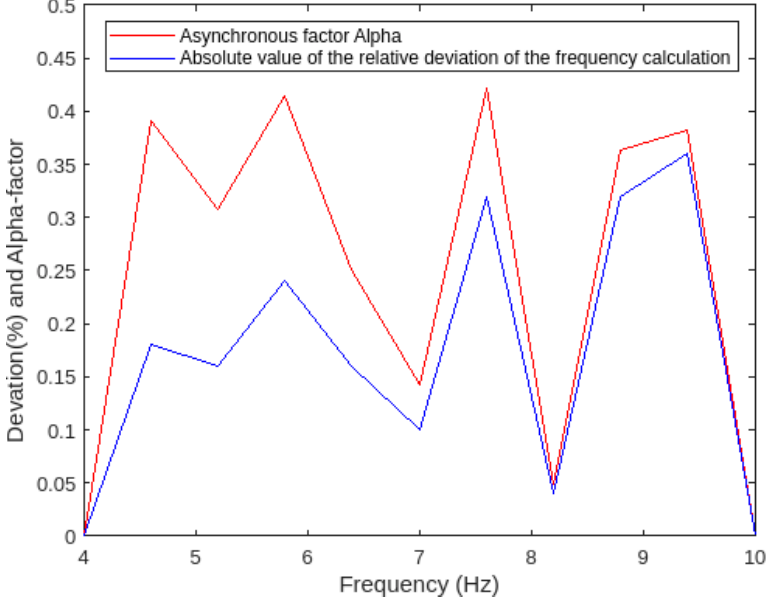
Figure 5. Measuring deviation of the DFS algorithm and the asynchronous factor 𝛼 .